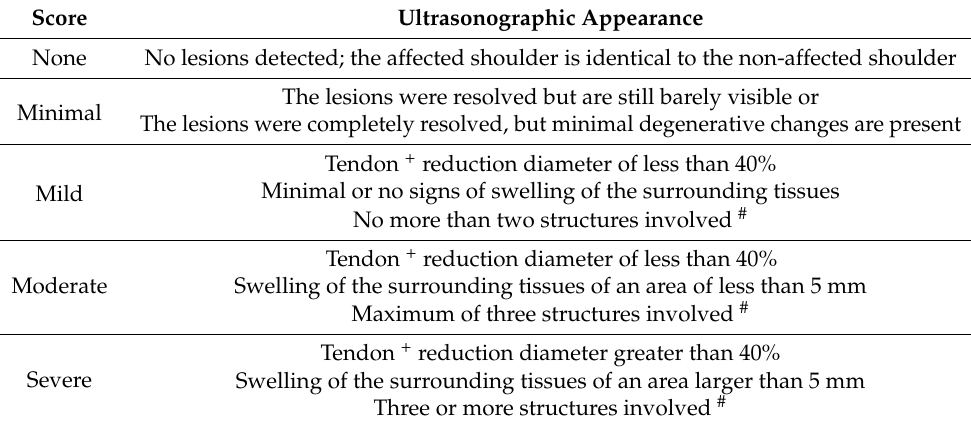
Table 2. Ultrasound Lesion Score